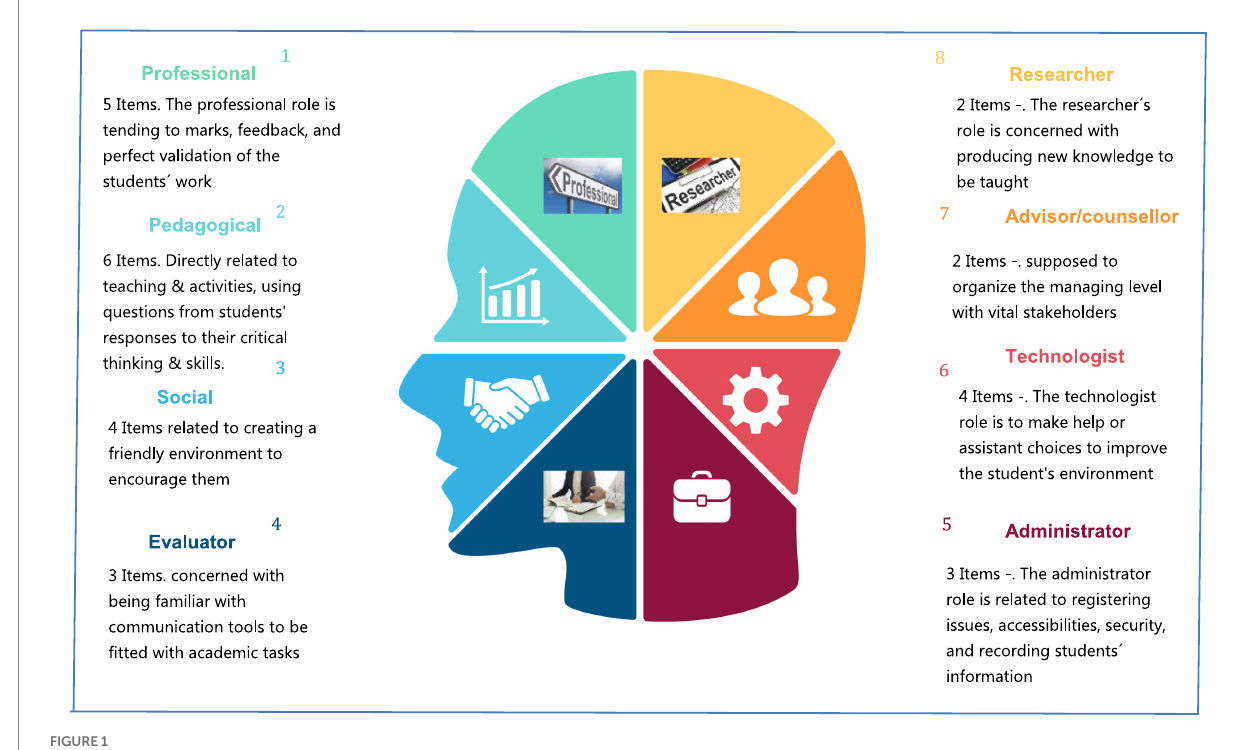
FIGURE 1 Research model of eight competency